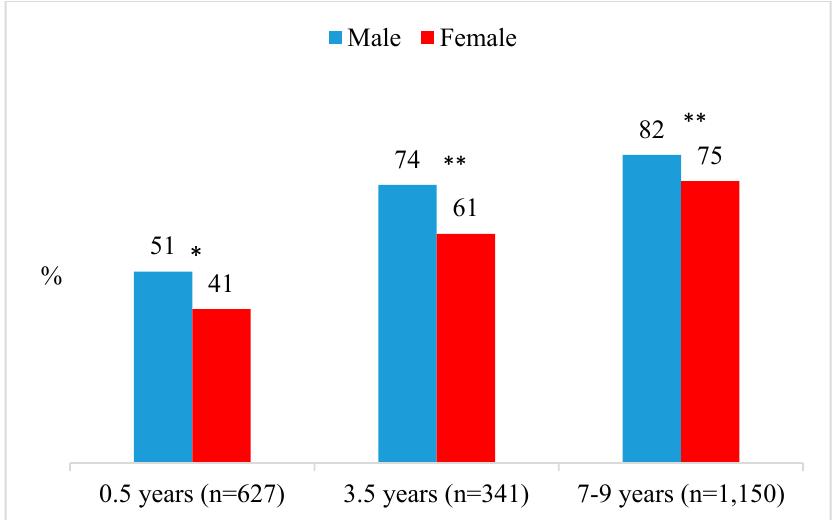
Figure 5. Proportion of doctoral graduates with a permanent position by gender and time elapsed since graduation (* p < 0.5, ** p < 0.01).